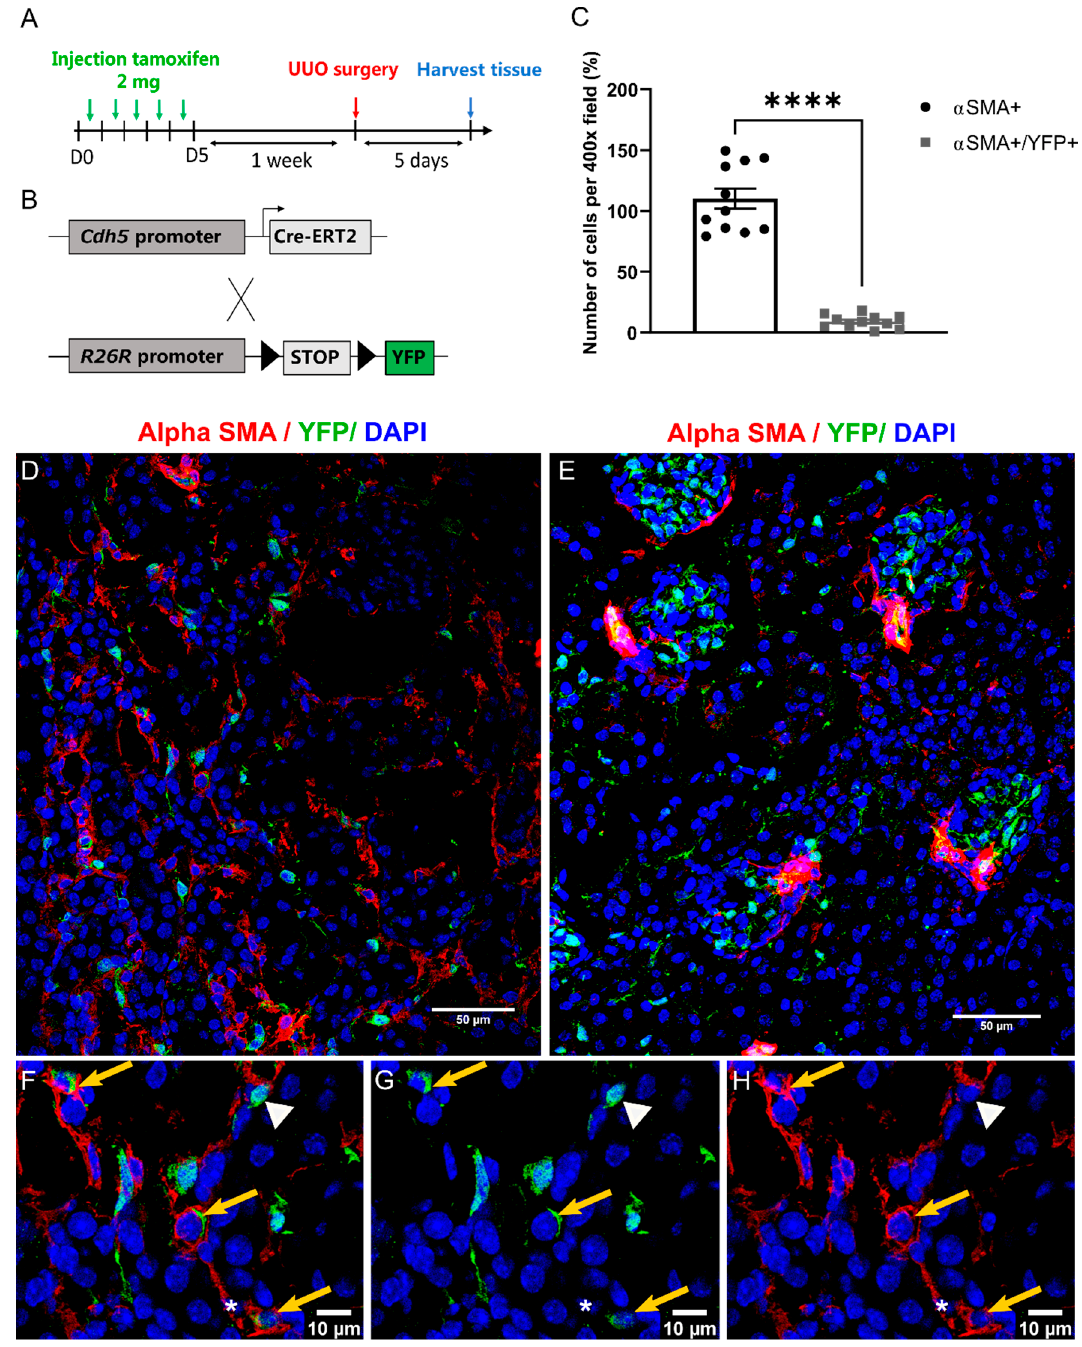
Figure 4. Endothelial-to-mesenchymal transition is present in fibrotic kidneys ( A ) Timeline for transgenic mouse kidney surgery and the experiment. ( B ) Schematic representation of Cdh5-Cre-ERT2; Rosa26R-stop-YFP mouse model. Cdh5- CreERT2 mouse allows the expression of the tamoxifen-inducible Cre recombinase under VE-cadherin promoter Cdh5. Cdh5-Cre-ERT2; Rosa26R-stop-YFP mice underwent UUO and were sacrificed 5 days later. Staining for α SMA and YFP (endothelial cell origin) was performed on healthy or post-UUO mouse kidneys. ( C ) Quantification of YFP+ α SMA+ and α SMA+ only cells in the fibrotic kidneys. ( D – H ) Representative image of healthy ( E ), fibrotic kidneys ( D ) and zoom of the fibrotic kidney ( F , G , H ). Co-stained YFP+ α SMA+ cells were indicated with a yellow arrow. Single YFP+ or α SMA+ cells were designated by a white arrowhead or white star respectively ( n = 3). Statistical significance was calculated by paired t -test (**** p <